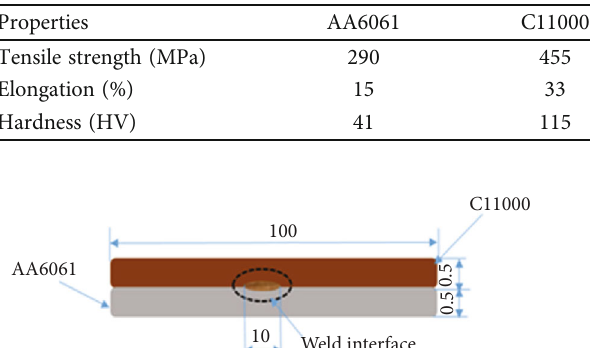
Table 2: Mechanical properties of AA6061 and C11000 used for the experimentation.